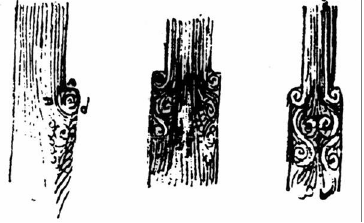
Figure 2: Three examples of vortices taken from the pictures by Leonardo da Vinci (cf. Frisch, 1995).